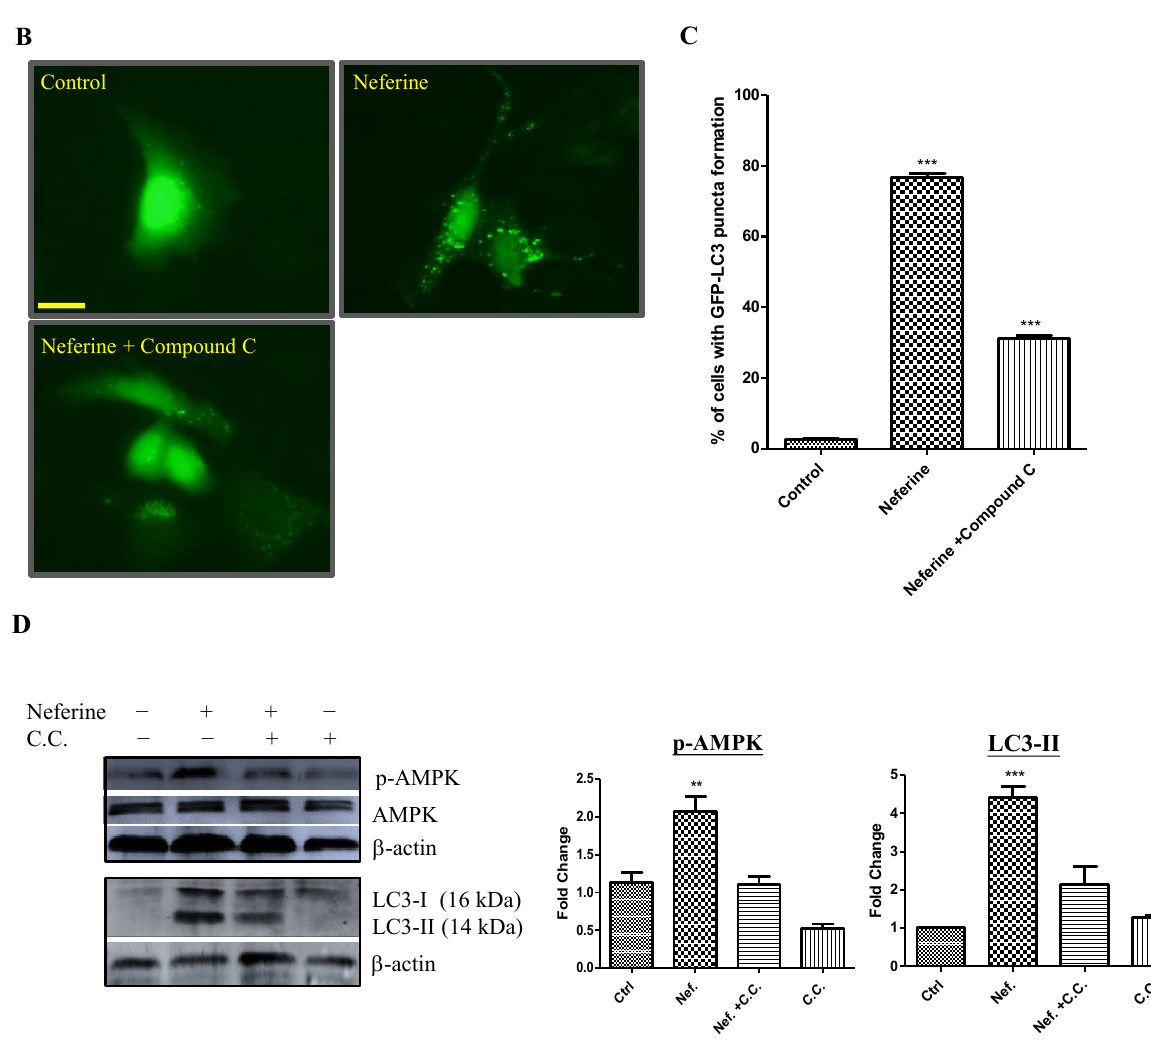
Figure 2. Neferine induces autophagy via activation of the AMPK-mTOR signaling pathway. ( A ) PC-12 cells were treated with neferine (7.5 µM) from 0–24 h. The increased level of phosphorylated AMPK was followed by a reduction in the phosphorylated level of p70S6K. Band intensities were quantified using densitometric analysis and normalized to β-actin or α-tubulin. ( B ) PC-12 cells transfected with GFP-LC3 were treated with 7.5 µM of neferine with the presence or absence of compound C (CC, 5 µM) for 12 h. Representative images demonstrated that the number of LC3-positive cells was smaller after compound C treatment. Magnification: ×40. Scale bar: 15 µm. ( C ) Bar chart representing the percentage of cells with GFP-LC3 puncta formation after treatments. Columns are the means of three independent experiments. ( D ) PC-12 cells were treated with neferine (7.5 µM) with the presence or absence of compound C (5 µM) for 24 h. The level of p-AMPK and LC3 II expression (14 kDa) was significantly lower after neferine treatment with the presence of compound C. Band intensities were quantified and normalized to β-actin. Data are expressed as the fold change relative to the DMSO-treated negative control. Bars: SD. *** p < 0.001; ** p <